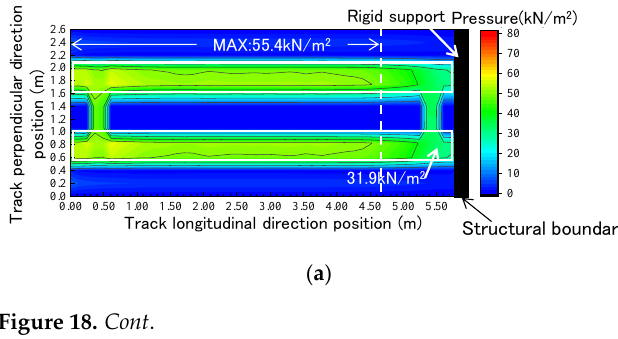
Figure 17. Distribution of the pressure on the sleeper bottom plane (CASE2): ( a ) ladder track; ( b ) PC sleeper track.